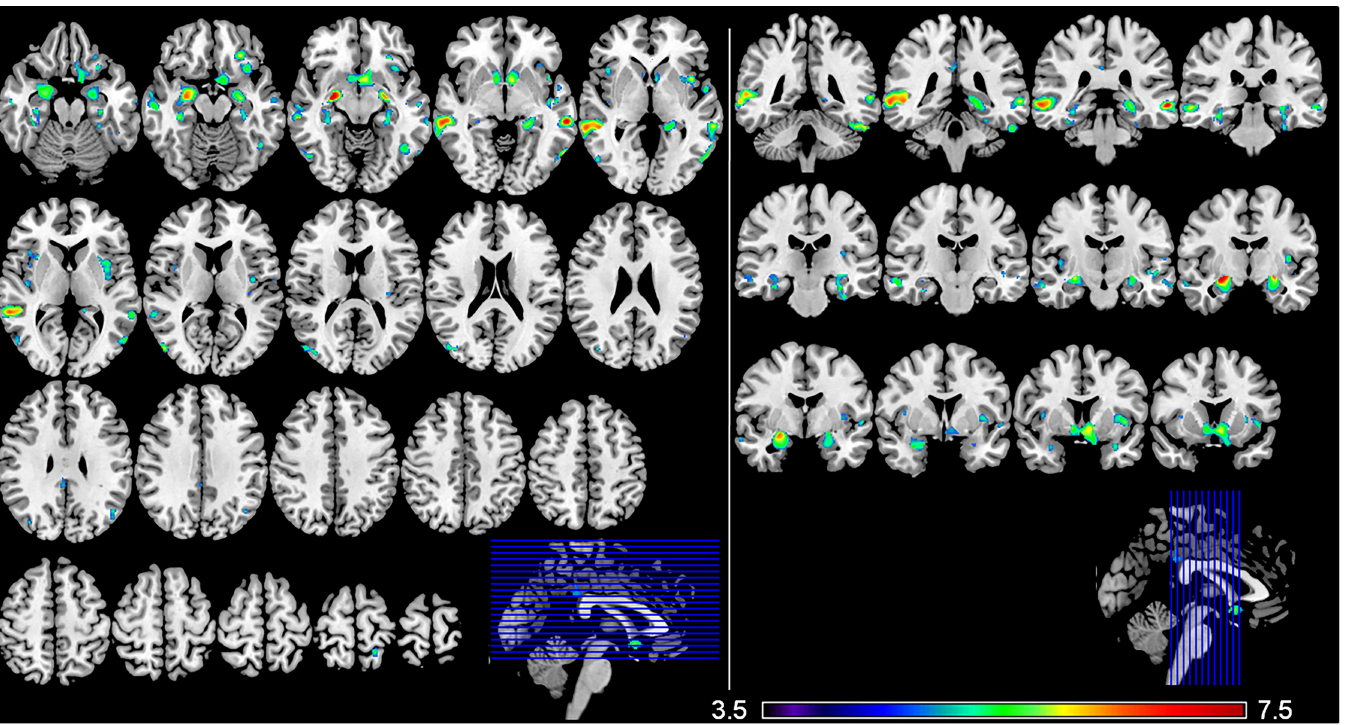
Fig 1. Gray matter regions showing a positive correlation with MMSE score. The statistical map is co-registered and superimposed on 3D-T1 (A) axial (MNI coordinates: z = -20 to z = +75) and (B) coronal slices (MNI coordinates: y = -42 to y = +12) (MNI T1 template availableon MRICRON software). Results are showed with a significance of P < 0.05 corrected for multiple comparisons (FWE-corrected). Colour bar indicatesthe t -score for the regression slopes (from blue colour [ t = 3.5] to red colour [ t =